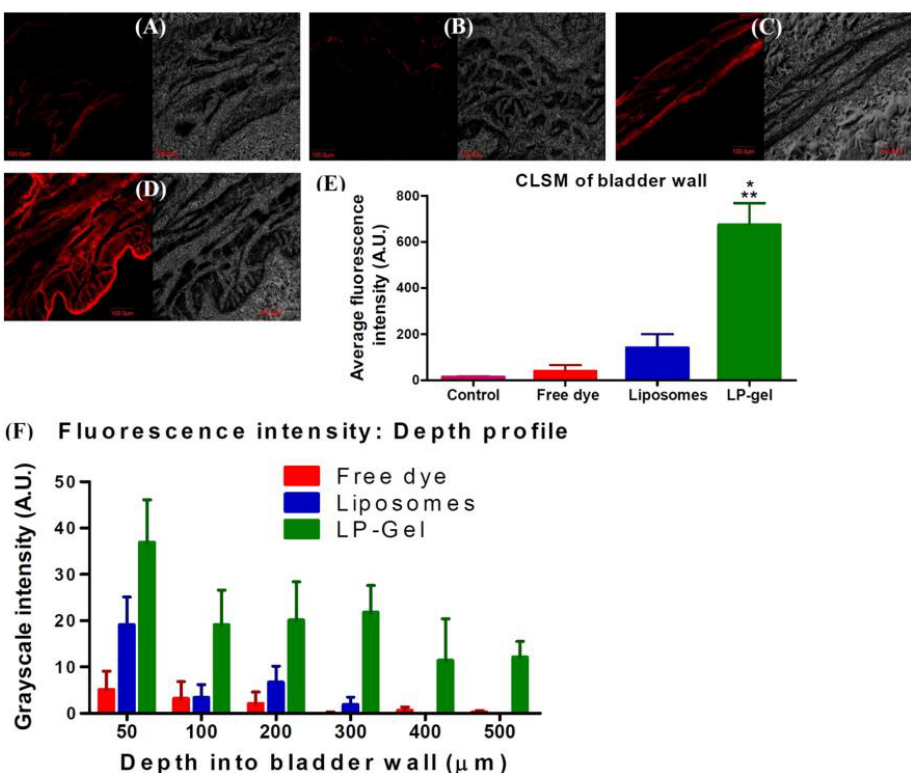
Figure 3. Confocal laser scanning micrographs (CLSMs) of cross-section of bladder wall (red filter and bright field): ( A ) Control bladder; ( B ) bladder with free dye (rhodamine-6G); ( C ) bladder with dye-loaded liposomes and ( D ) bladder with dye-loaded LP-Gel (scale bar for all images = 100 μm). Analysis of CLSM images: ( E ) average fluorescence intensities (* p < 0.05 compared to free dye, ** p < 0.05 compared to liposomes) and ( F ) depth profile of fluorescence intensities ( p < 0.05 from two-way ANOVA). Reproduced with permission from [109], Elsevier